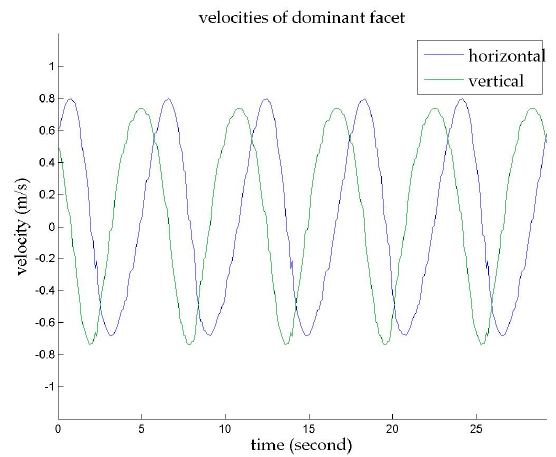
Figure 12. Horizontal velocity and vertical velocity of the dominant facet F 0 . The velocities are calculated according to Equations (5) and (6), in which the variation of spatial position ( x , z ) of the dominant facet is also taken into account.